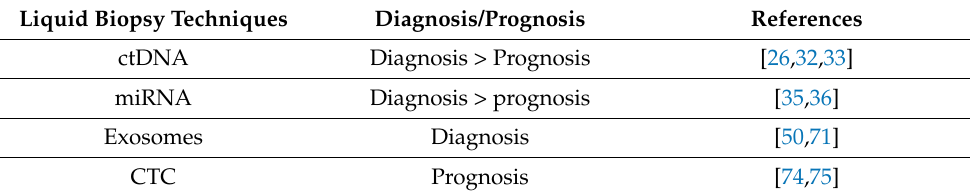
Table 2. Liquid biopsy technical approaches for oral squamous cell carcinoma (OSCC) diagnosis and